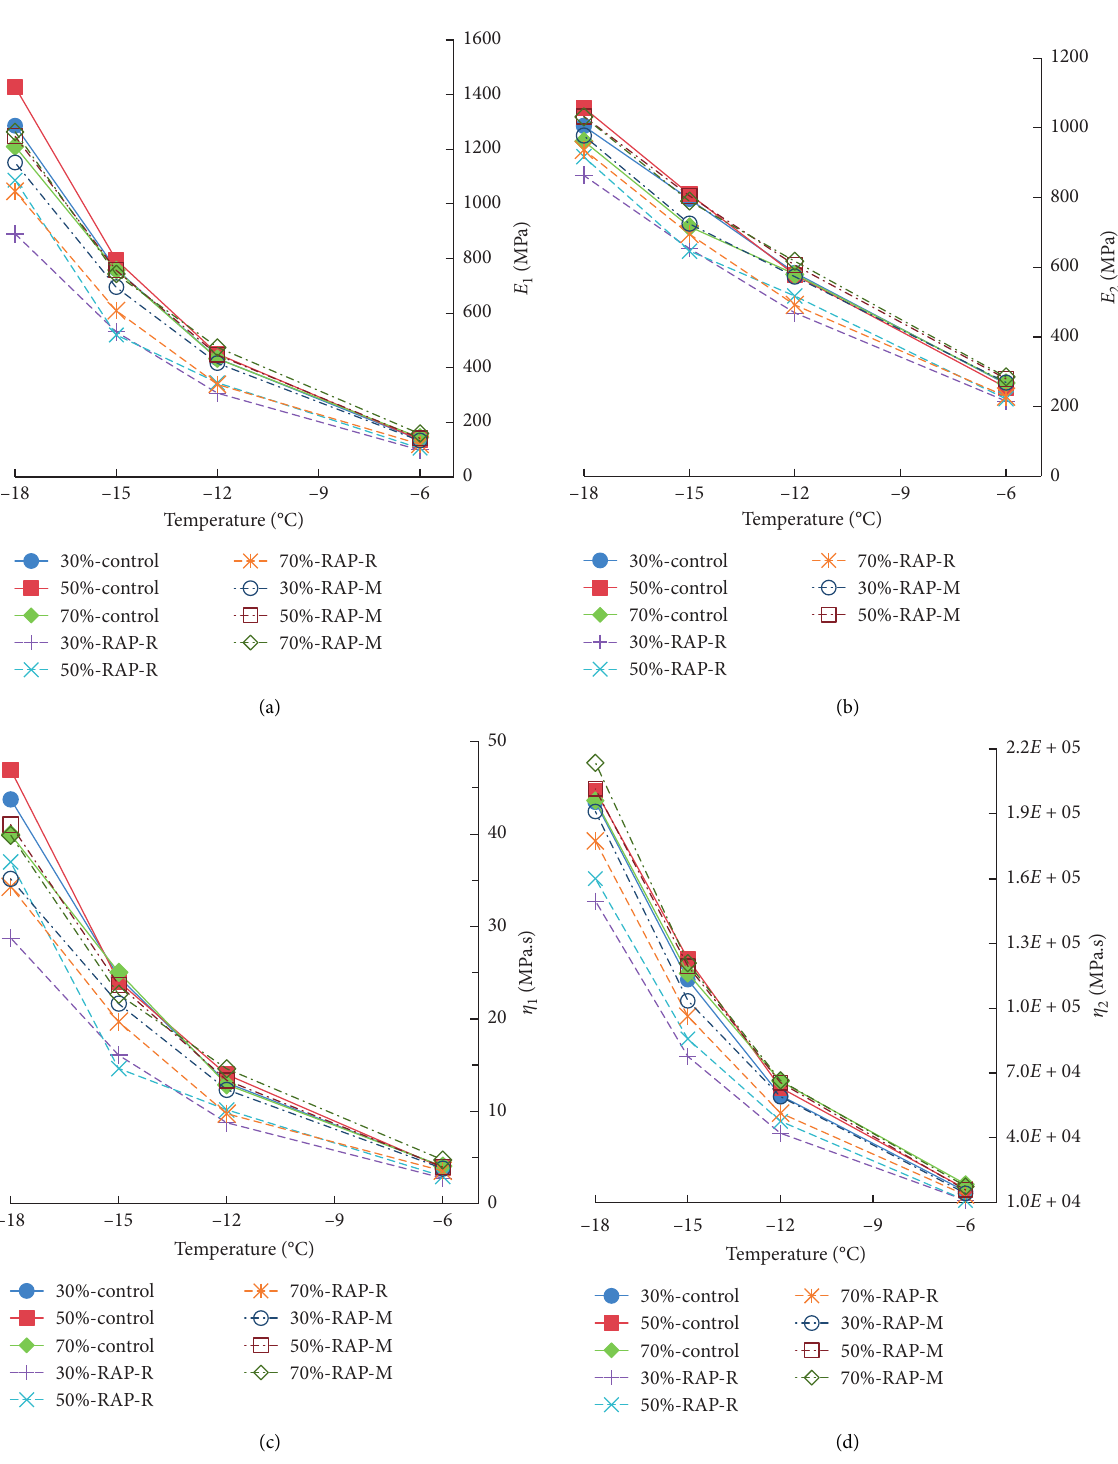
. (b) Instant elastic 1